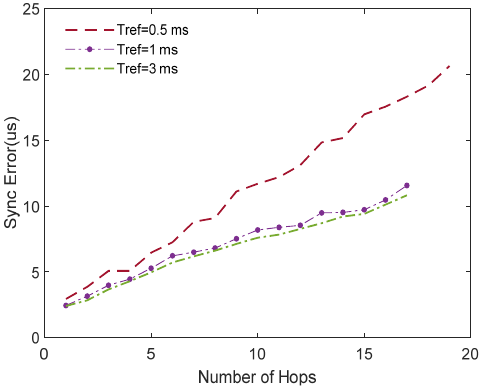
Figure 7. Synchronization error comparison of different T ref .